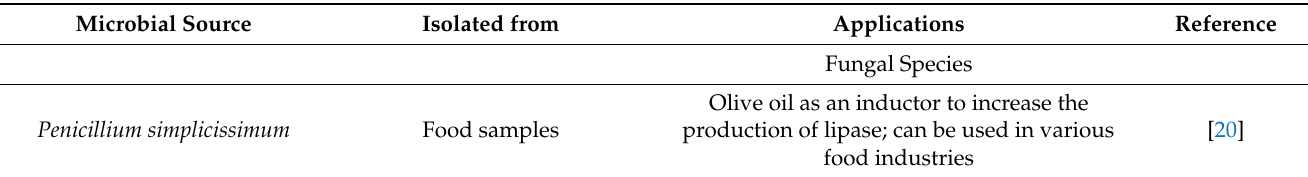
Table 1. Microbial sources of lipases from diverse